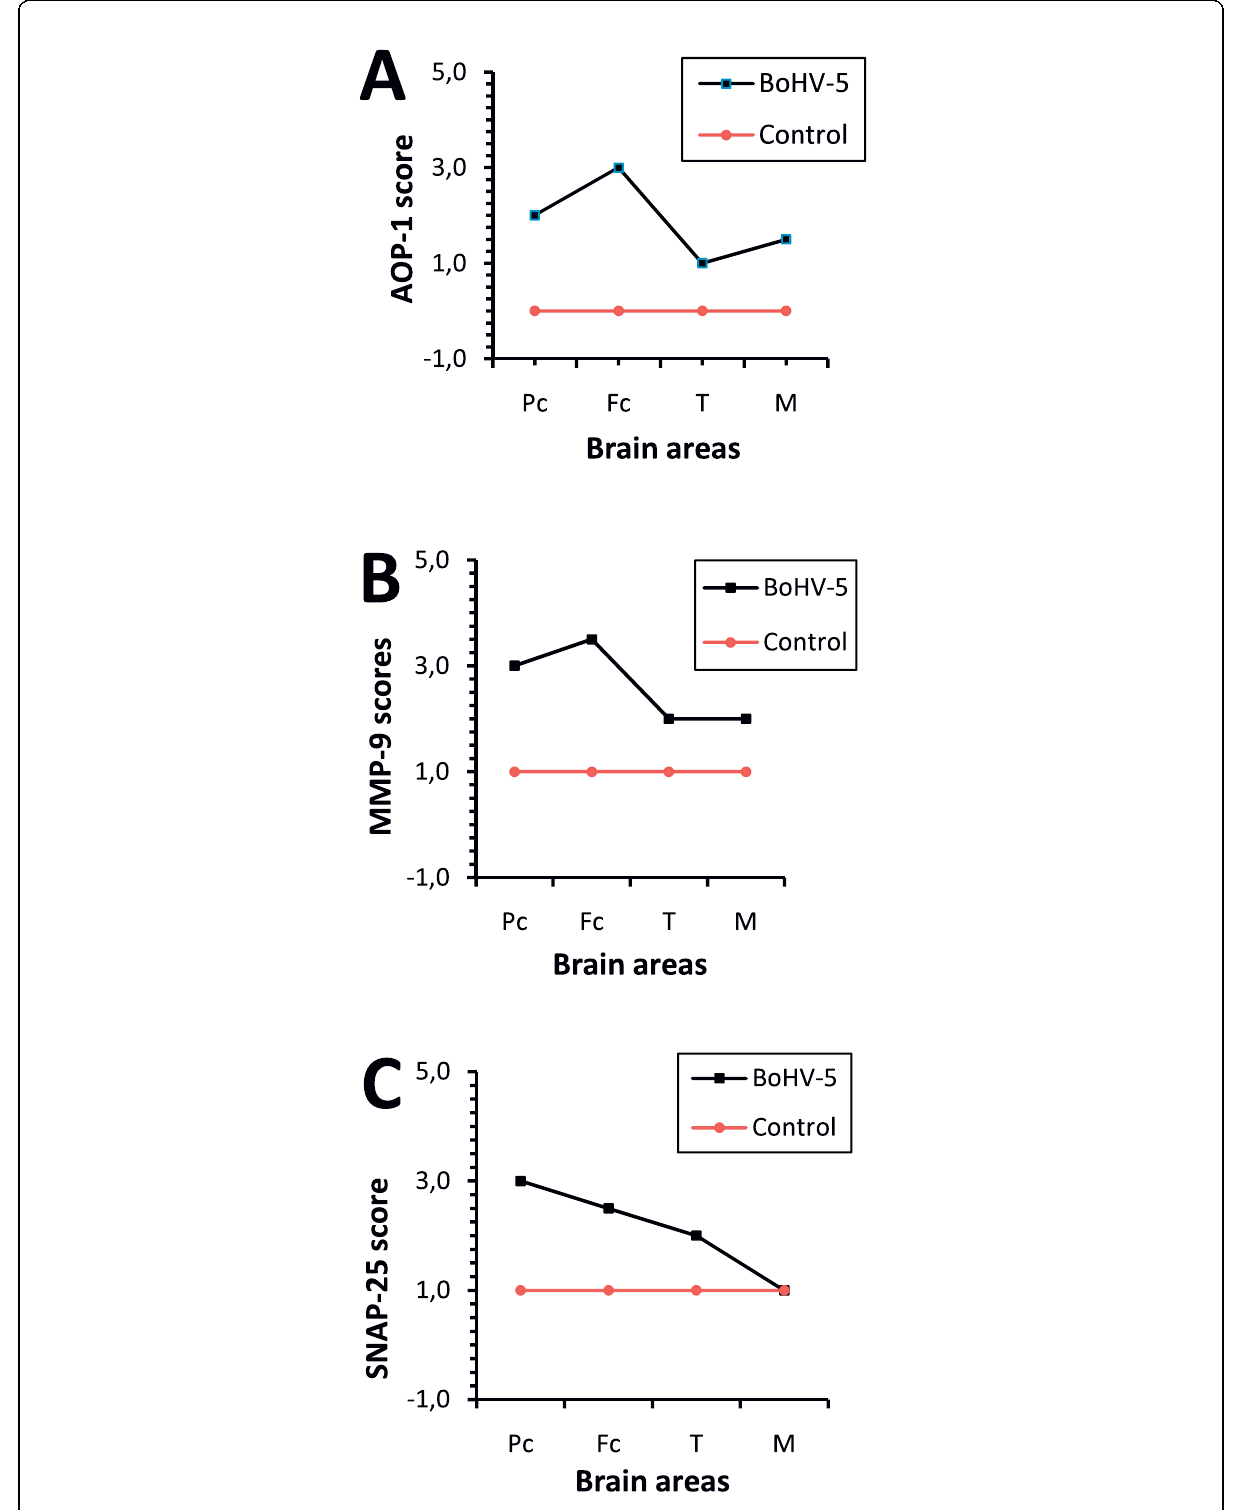
Figure 2 Frequency of detection of antigens . AOP-1 (A), MMP-9 (B) and SNAP-25 (C) proteins in different brain areas (Pc, Fc, T and M; x-axis) of naturally infected calves (n = 20) and a control group scored on a scale of 1 to